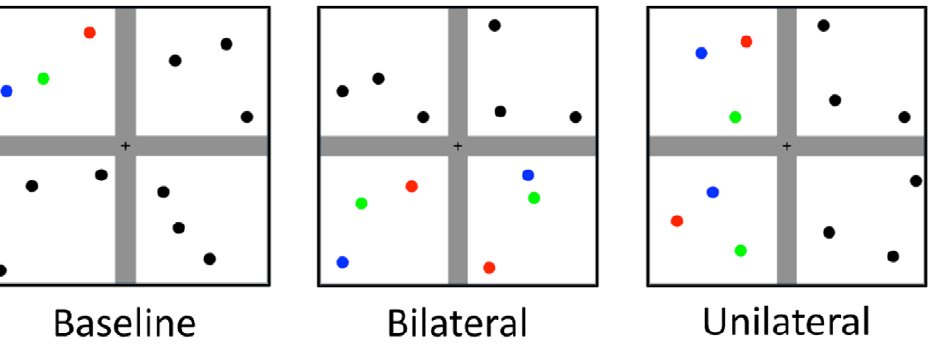
Figure 1. Schematic depiction of the three trial conditions for Experiment 1. Targets are divided between both visual hemifields on bilateral trials, and confined to one hemifield on unilateral trials.